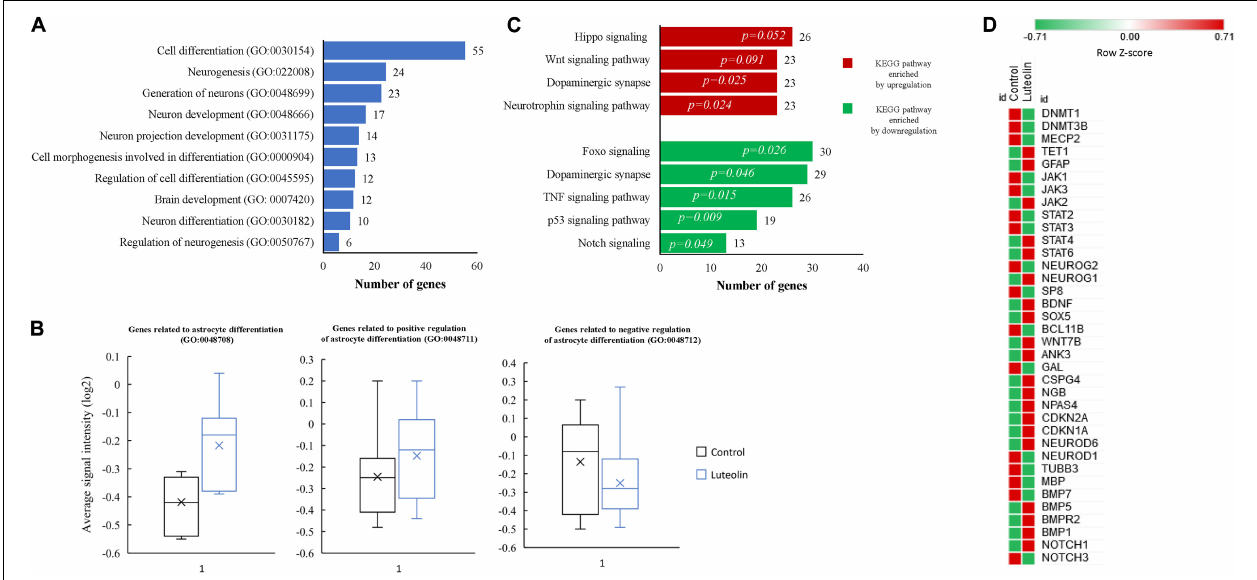
FIGURE 1 | Luteolin affected biological processes and directed differentiation of hNSCs toward astrocytes. (A) Top 10 significantly enriched biological processes between 1 µ M luteolin treated hNSCs and untreated control hNSCs. (B) Box plots showing the signal intensity of genes involved in astrocyte differentiation (7 genes averaged), positive regulation of astrocyte differentiation (13 genes averaged), and negative regulation of astrocyte differentiation (17 genes averaged). Each box represents the quartile values, the error bar represents the SD, the midline represents the median value and the multiplication sign denotes the mean in signal intensities between control and luteolin-treated hNSCs was tested using student’s t -test. (C) Top significantly regulated KEGG signaling pathways. (D) Heat map showing expression intensities (log2 transformed) of genes involved in NSC differentiation between luteolin-treated (1 µ M) hNSCs and untreated control hNSCs (Heat map plotted using the following online tool http://www.heatmapper.ca/; Sasha Babicki, David Arndt, Ana Marcu, Yongjie Liang, Jason R. Grant, Adam Maciejewski, and David S. Wishart. Heatmapper: web-enabled heat mapping for all. Nucleic Acids Res. 2016 May 17).